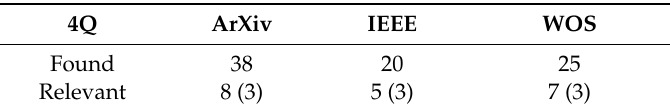
Table 4. Results from the search after “Image captioning” search query with filtered date to 2019 as we aimed for the newest articles